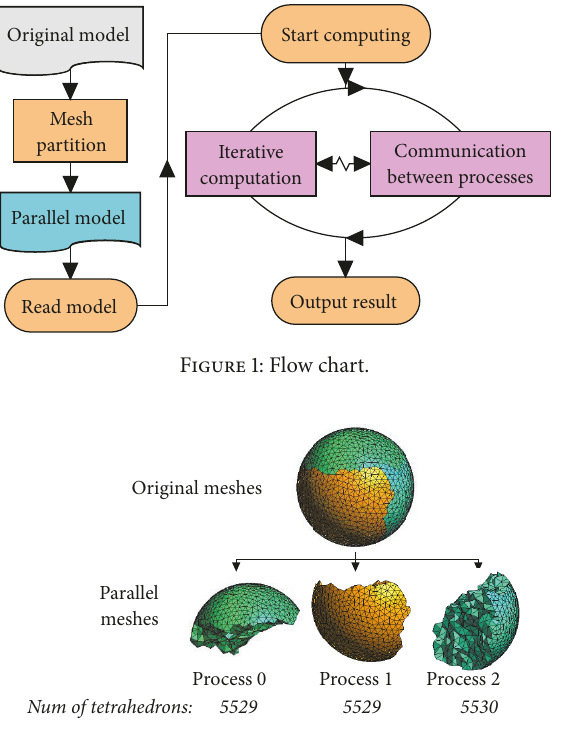
Figure 2: Mesh partition.